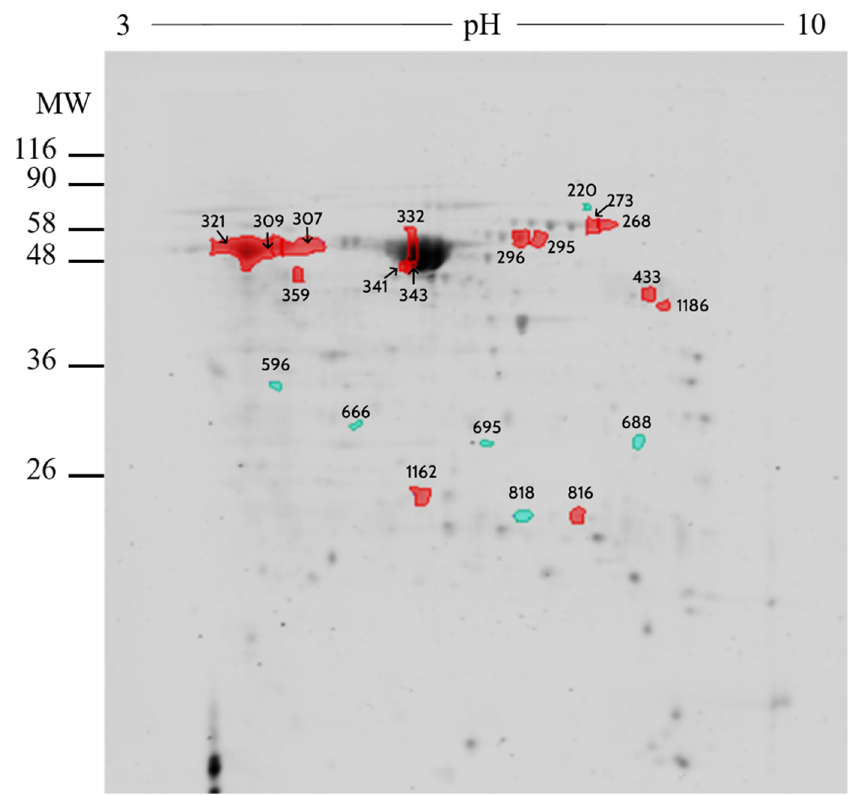
Figure 2. 2D gel electrophoresis comparing oviduct fluid from ampulla between pregnant vs. cyclic heifers. Resolution of 150 µg of oviduct fluid in Maxi gel with non-linear gradient strips of pH 3–10 stained with Coomassie Blue. Image analysis was performed with SameSpots v.4.0 software. Spots marked in green correspond to the proteins more abundant in pregnant heifers, while spots marked in red were more abundant in cyclic heifers. MW: molecular weight. Table 1. Proteins identified by MS / MS in the oviduct fluid from ampulla of pregnant vs. cyclic heifers.